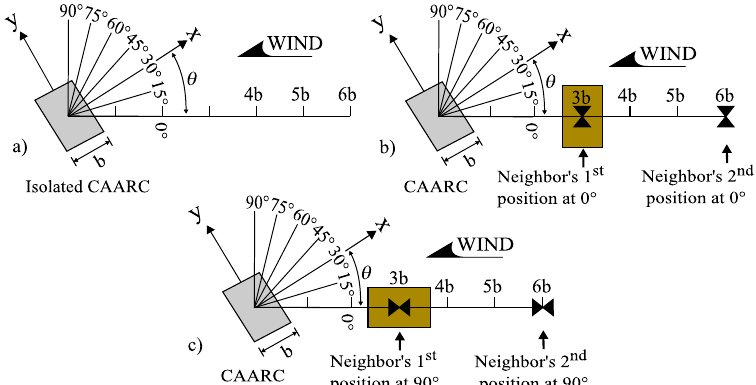
Figure 3. Top view of wind direction, neighbor’s configurations and CAARC orientation angles θ , for the cases: a) isolated; b) with neighbor at 0°; and c) with neighbor at 90°.